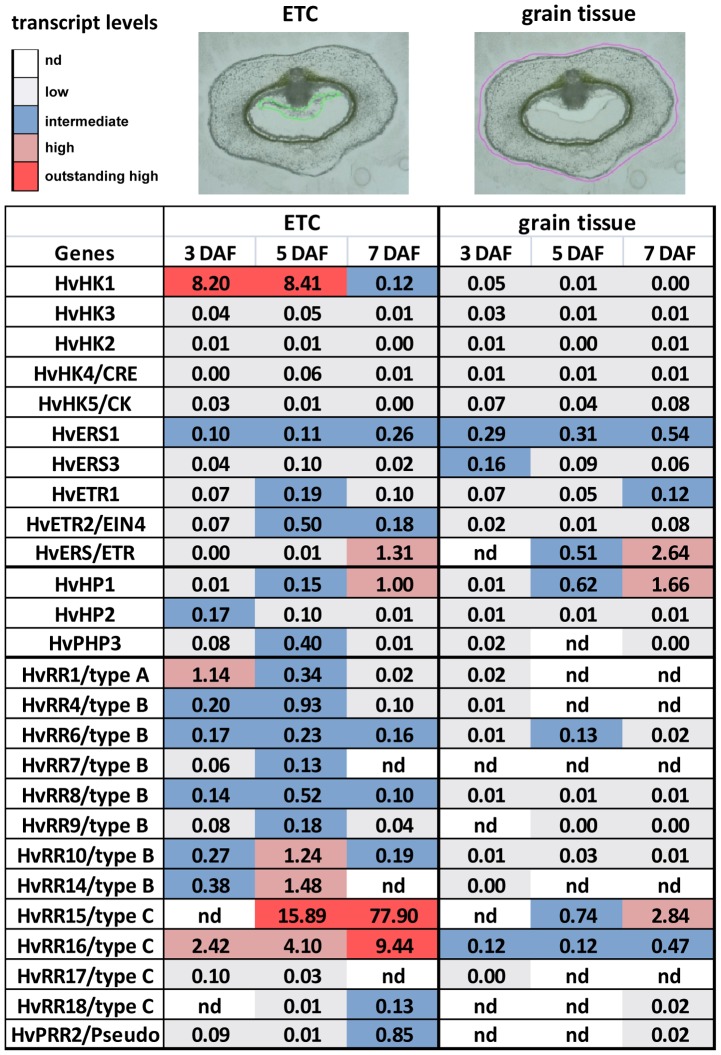
Transcript levels of barley TCS elements in ETCs and grain tissues determined by qRT-PCR analyses.At the top, cross-sections of a barley grain at 3 DAF are given as an example for targets used in qRT-PCR analyses. ETC regions at different stages were isolated by LMPC (encircled in green) and the complete leftovers of the tissue sections, e.g. the whole grain tissues without the ETCs, have been collected separately (encircled in purple). Relative expression levels are illustrated by colour code: white- not detectable (nd), light blue- >0–<0.1/low, blue- 0.1–<1.0/intermediate, pink- 1.0–5.0/high, red- >5.0/very high. Assignment of TCS elements according to Table 2.